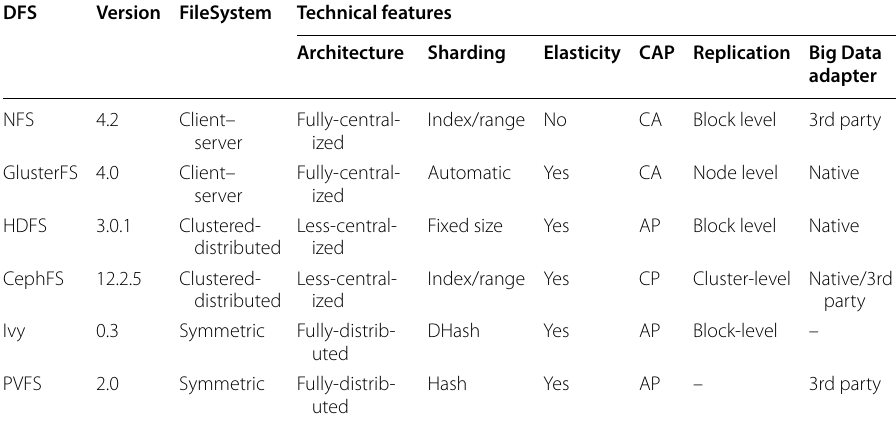
Table 3 Feature analysis of selected DFSs